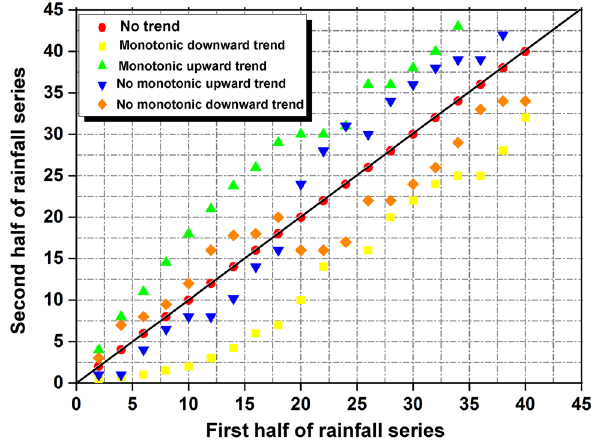
Fig. 2 Şen’s innovative trend methodology